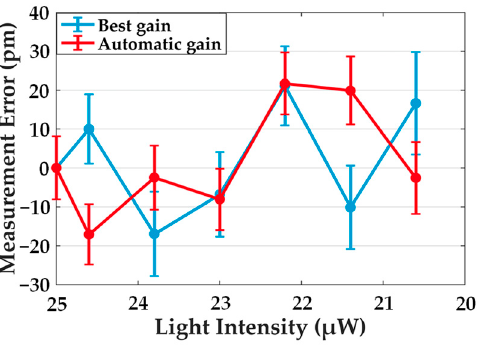
Figure 9. Results of displacement compensation method under different light intensities.